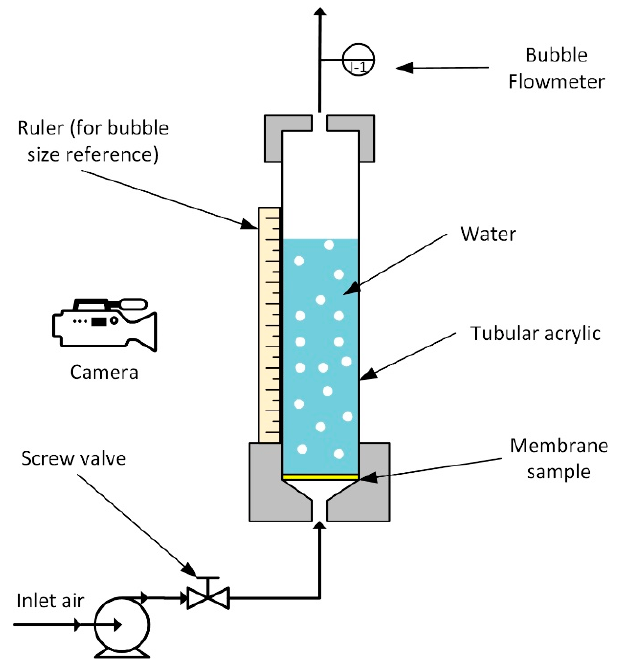
Figure 1. Custom experiment set-up.